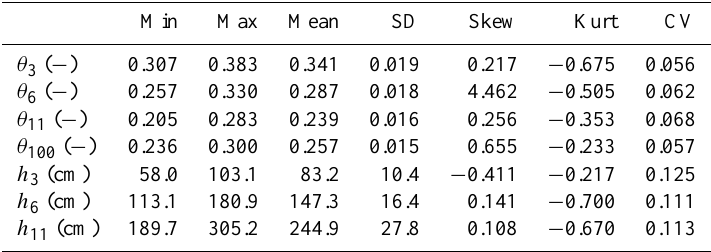
Table 1. Descriptive indices of the spatial series observed along the transect at 0.3m depth of soil profile.